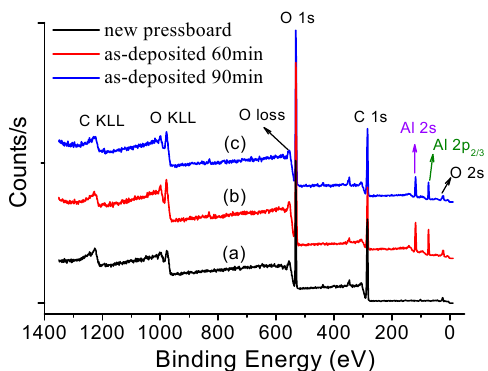
Figure 5. X-ray photoelectron spectroscopy (XPS) of fresh pressboard surface ( a ); pressboard surface sputtered for 60 min ( b ) and 90 min ( c ).